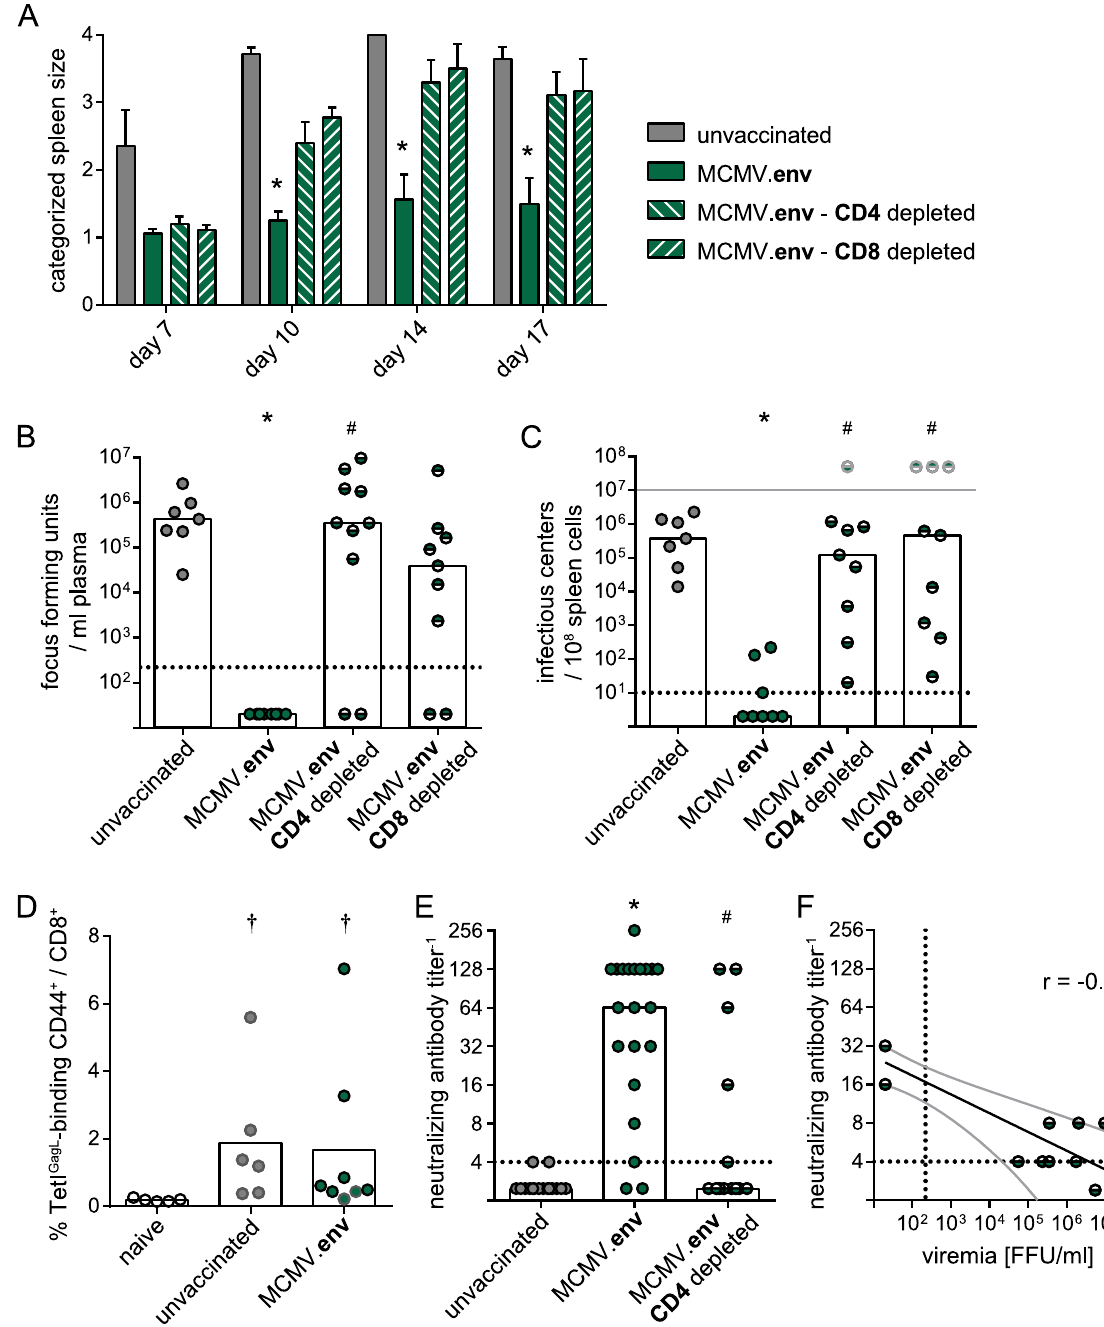
Fig 9. Contribution of CD4 + and CD8 + T cells to protection from FV challenge. CB6F1 mice were immunized twice with MCMV.env in a three-week interval, and depleted of CD4 + or CD8 + T cells five weeks after the first immunization. Mice were infected with FV one week later, and development of splenomegaly was monitored by twice-weekly palpation of the spleens (A). Viremia levels were determined in blood samples collected 10 days after FV infection (B); spleens were isolated three weeks after FV infection and spleen viral loads were analysed (C); pale symbols indicate mice that were sacrificed prior to the end of the experiment due to FV-induced disease in accordance with termination criteria, pale symbols do not represent actual values. The CD8 + T cell response to the Leader-Gag-derived GagL 85-93 epitope was analysed ten days after FV challenge by MHC I tetramer staining, dots with black borders indicate mice that controlled FV-induced splenomegaly, dots with grey lines indicate mice that did not control FV-induced splenomegaly (D). The neutralizing antibody response in CD4 + or CD8 + cell depleted mice was analysed ten days after FV challenge (E). (F) Spearman correlation analysis was performed for neutralizing antibody levels in MCMV. env immunized, CD4 + cell-depleted mice before FV challenge infection with the viremia levels 10 days after FV infection. Each dot indicates an